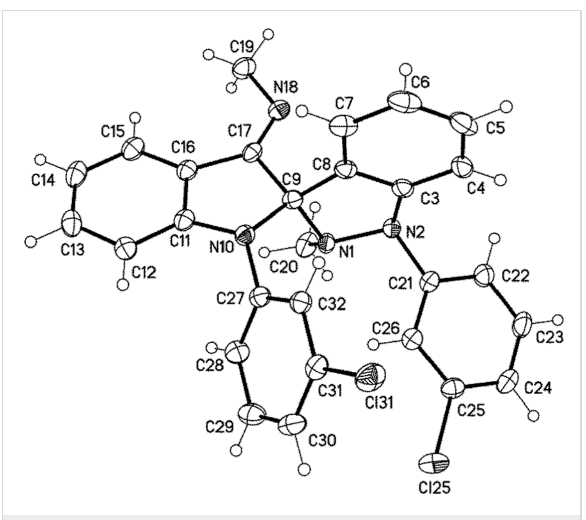
Figure 2: Molecular structure of 14c , displacement parameters are drawn at 50% probability